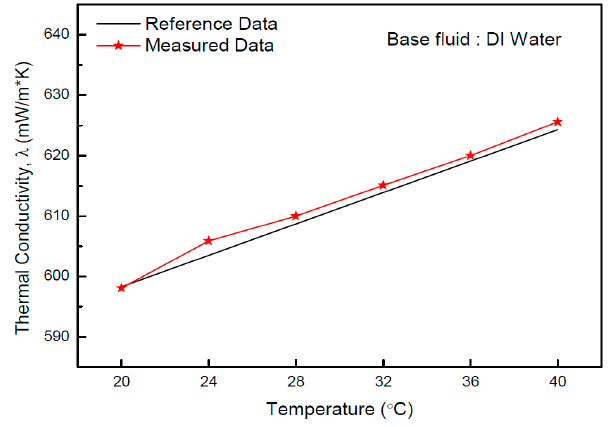
Figure 4. The measured thermal conductivity for the base fluid.